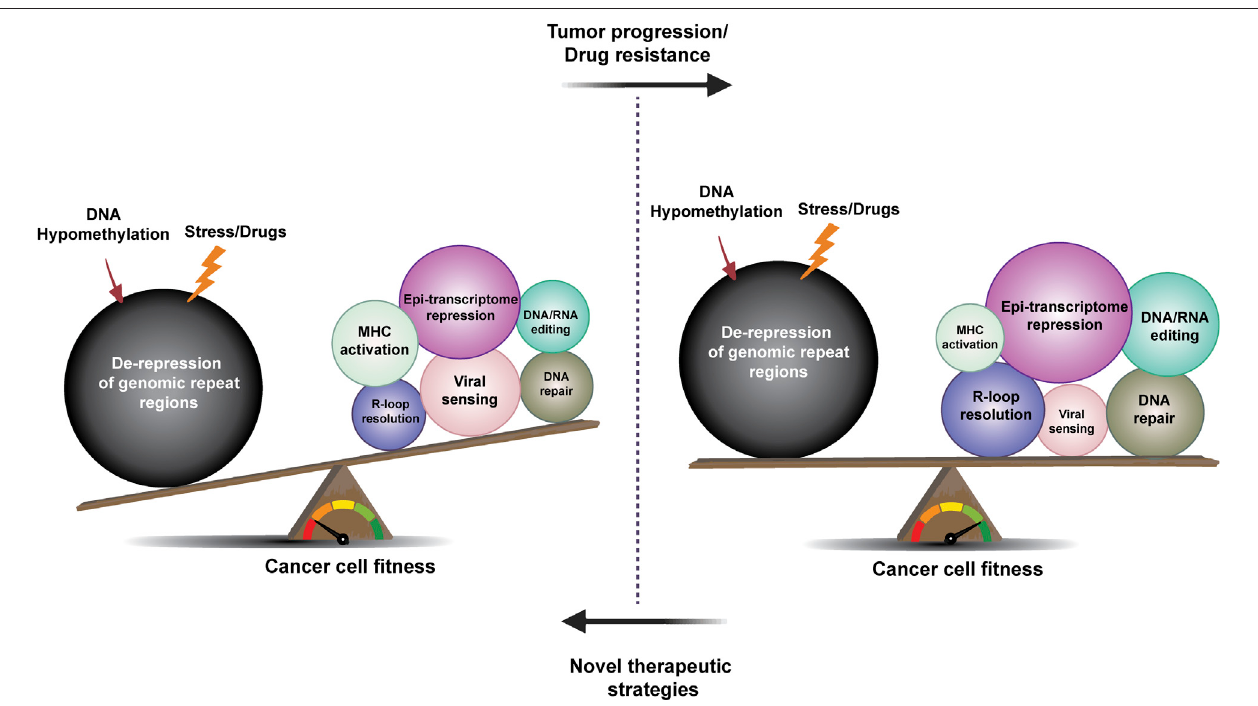
FIGURE4| Therheostatofrepeatelementde-regulationandrestrictionintumorevolutionanddrugresistance.Theevolutionofcanceranddrugresistancemaybe describedasabattlebetweenfactorsthatdecreaseandpromotetumor fi tnessandimmunogenicity.Upondrug-inducedstressorDNAhypomethylation,de-repression of repeat elements leads to loss of cancer cell fi tness and activation of innate and adaptive tumor immunity, in part driven by viral sensing and DDR mechanisms (left). Compensatory mechanisms, such as epi-transcriptome regulation, DNA repair, DNA/RNA editing, and R-loop resolution factors can all contribute to the establishmentofabalancethatpromotestumordevelopmentandtheevolutionofdrugresistance(asindicatedbythechangesincirclesizeintherightpartofthe fi gure). Future studies will determine whether new tumor therapy strategies aimed at disrupting this balance can result in more curative outcomes.